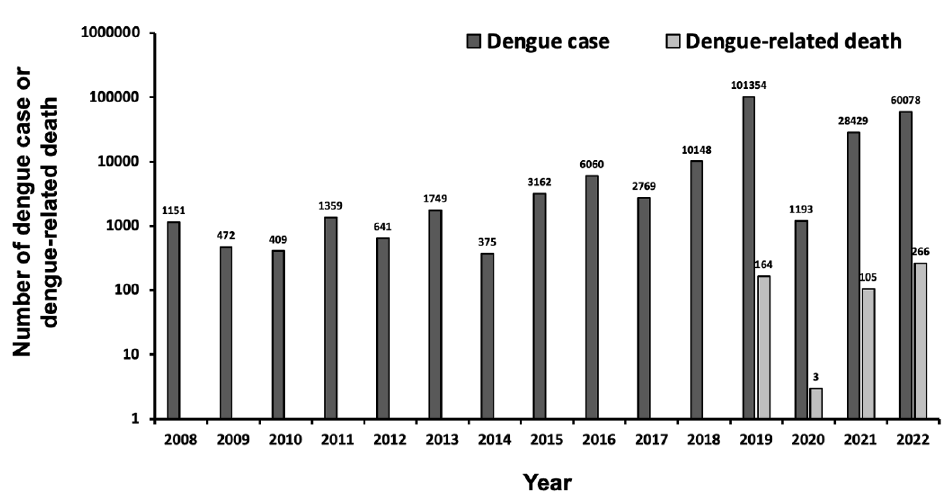
Figure 1. Number of reported dengue case and dengue-related death per year in Bangladesh between 2008 and 10 December 2022.